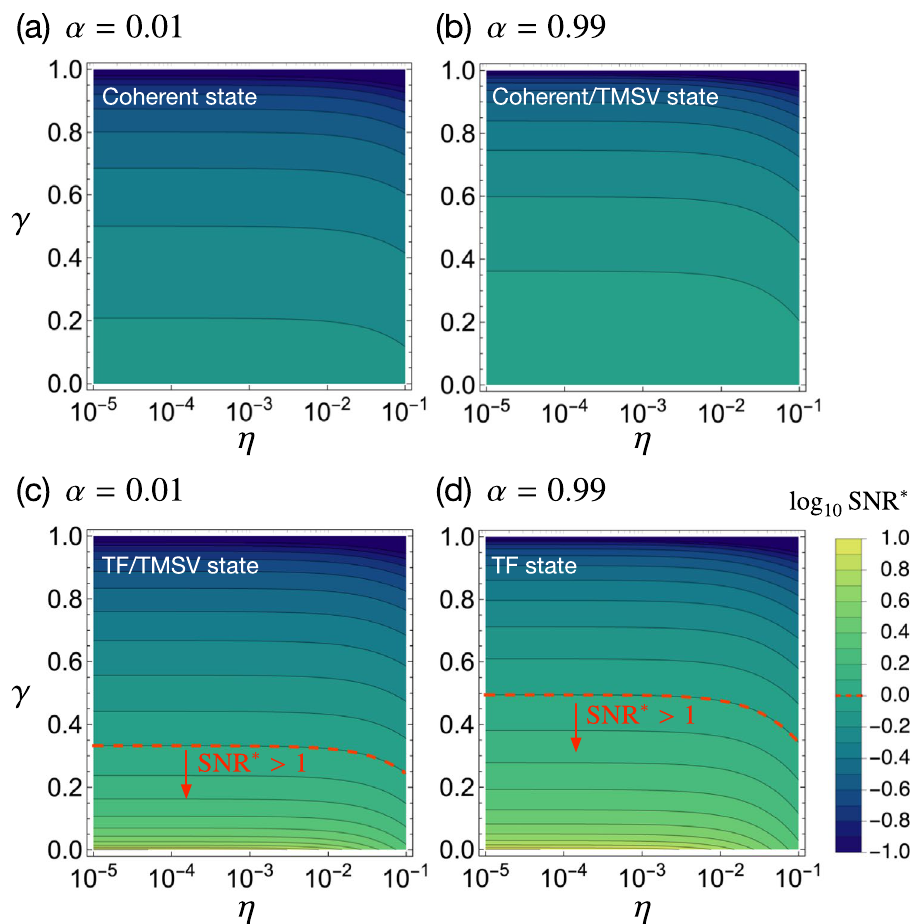
1 assumed as an example. =